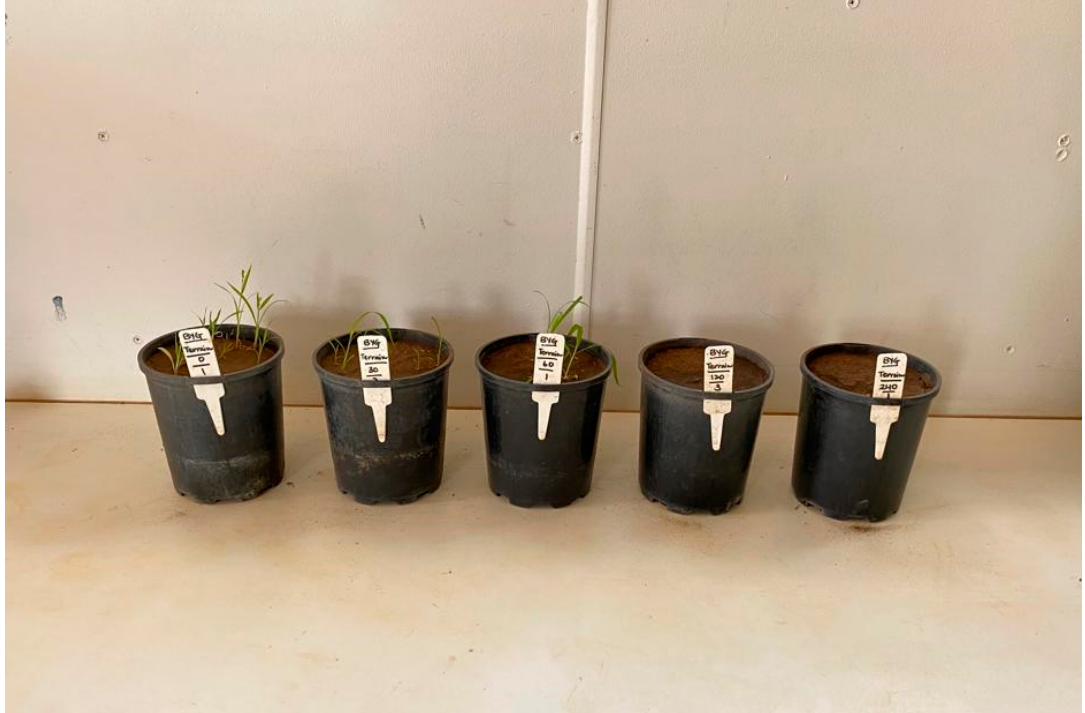
Figure 2. Echinochloa colona seedlings in response to flumioxazin doses (Left to Right: Flumioxazin doses are in increasing order: 0, 15, 30, 60, and 120 g ai ha − 1 . Metribuzin at higher doses was found to be effective against E. colona (Table 4). Metribuzin at 72 g ai ha − 1 and 144 g ai ha − 1 reduced the biomass of E. colona by 70 and 100% compared to the non-treated control, respectively. The biomass of the rice was reduced by 35, 88, and 100% compared with the non-treated control when metribuzin was applied at 72, 144, and 288 g ai ha − 1 ,